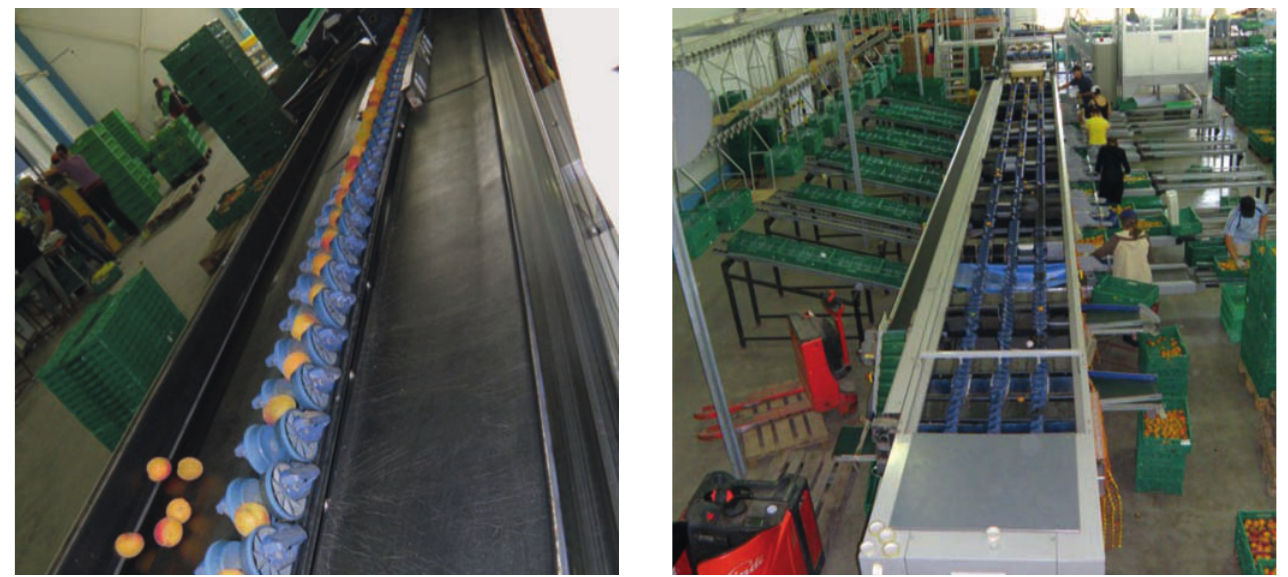
Fig. 5: Grading carriers line Fig. 6: Three-line grading machine with one-side conveyor